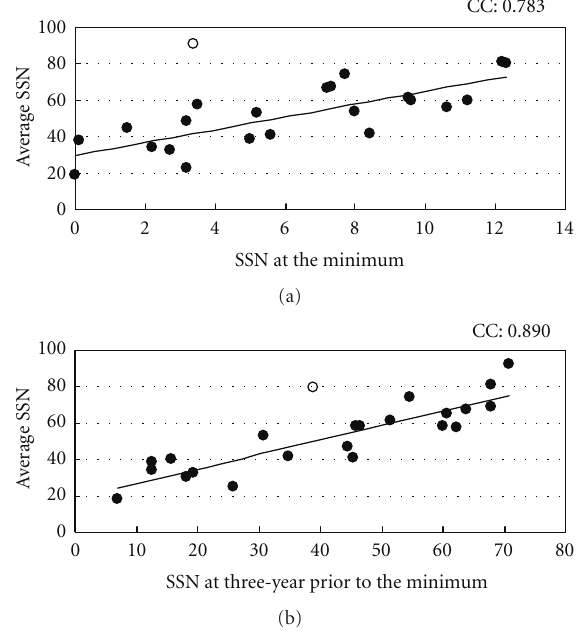
Figure 4: (a) Average sunspot number divided at the minimum versus the minimum sunspot number. (b) Average sunspot number divided at a point three years before the minimum versus the sunspot number at the dividing point. CC on the top right-hand side of each map represents the correlation coe ffi cient. Outliers plotted by white circles in the maps are omitted in the calculation of the correlation coe ffi